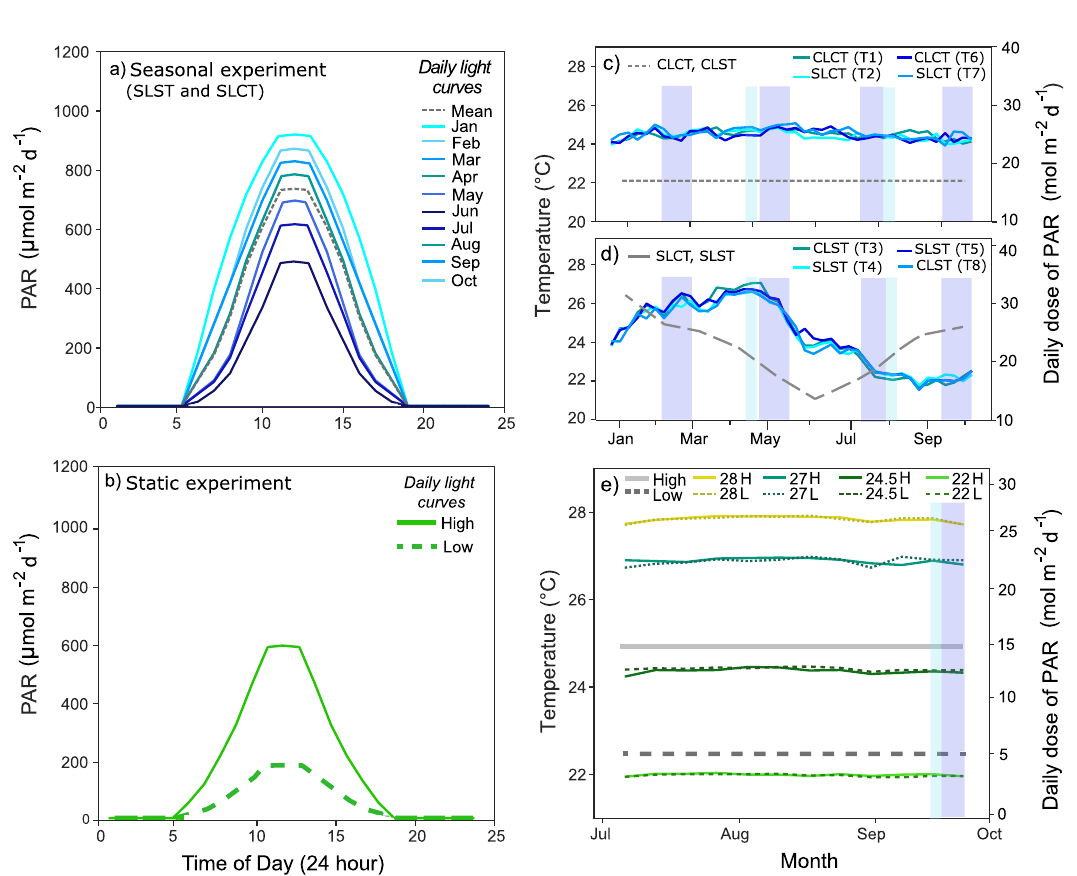
Fig. 5 Temperature and light treatments. a Seasonal range in the diurnal light cycles for the seasonal experiment, and ( b ) the high and low diurnal light cycles for the static experiment. c , d Weekly averaged seawater temperature (blue lines) and daily PAR (grey lines) in the seasonal study, and ( e ) seawater temperature (green and yellow lines) and daily PAR (grey lines) in the static experiment. Dark blue shading denotes the intervals re fl ected in coral skeletal sampling for geochemistry. The light blue shading indicates when photosynthesis and respiration rate measurements were conducted. Treatment conditions are the following: constant light and constant temperature (CLCT), seasonal light and constant temperature (SLCT), constant light and seasonal temperature (CLST), and seasonal light and seasonal temperature;